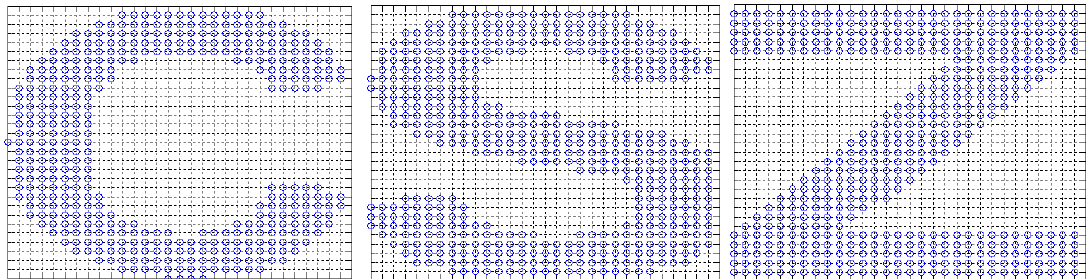
Figure 5. The regular distribution of nodes.